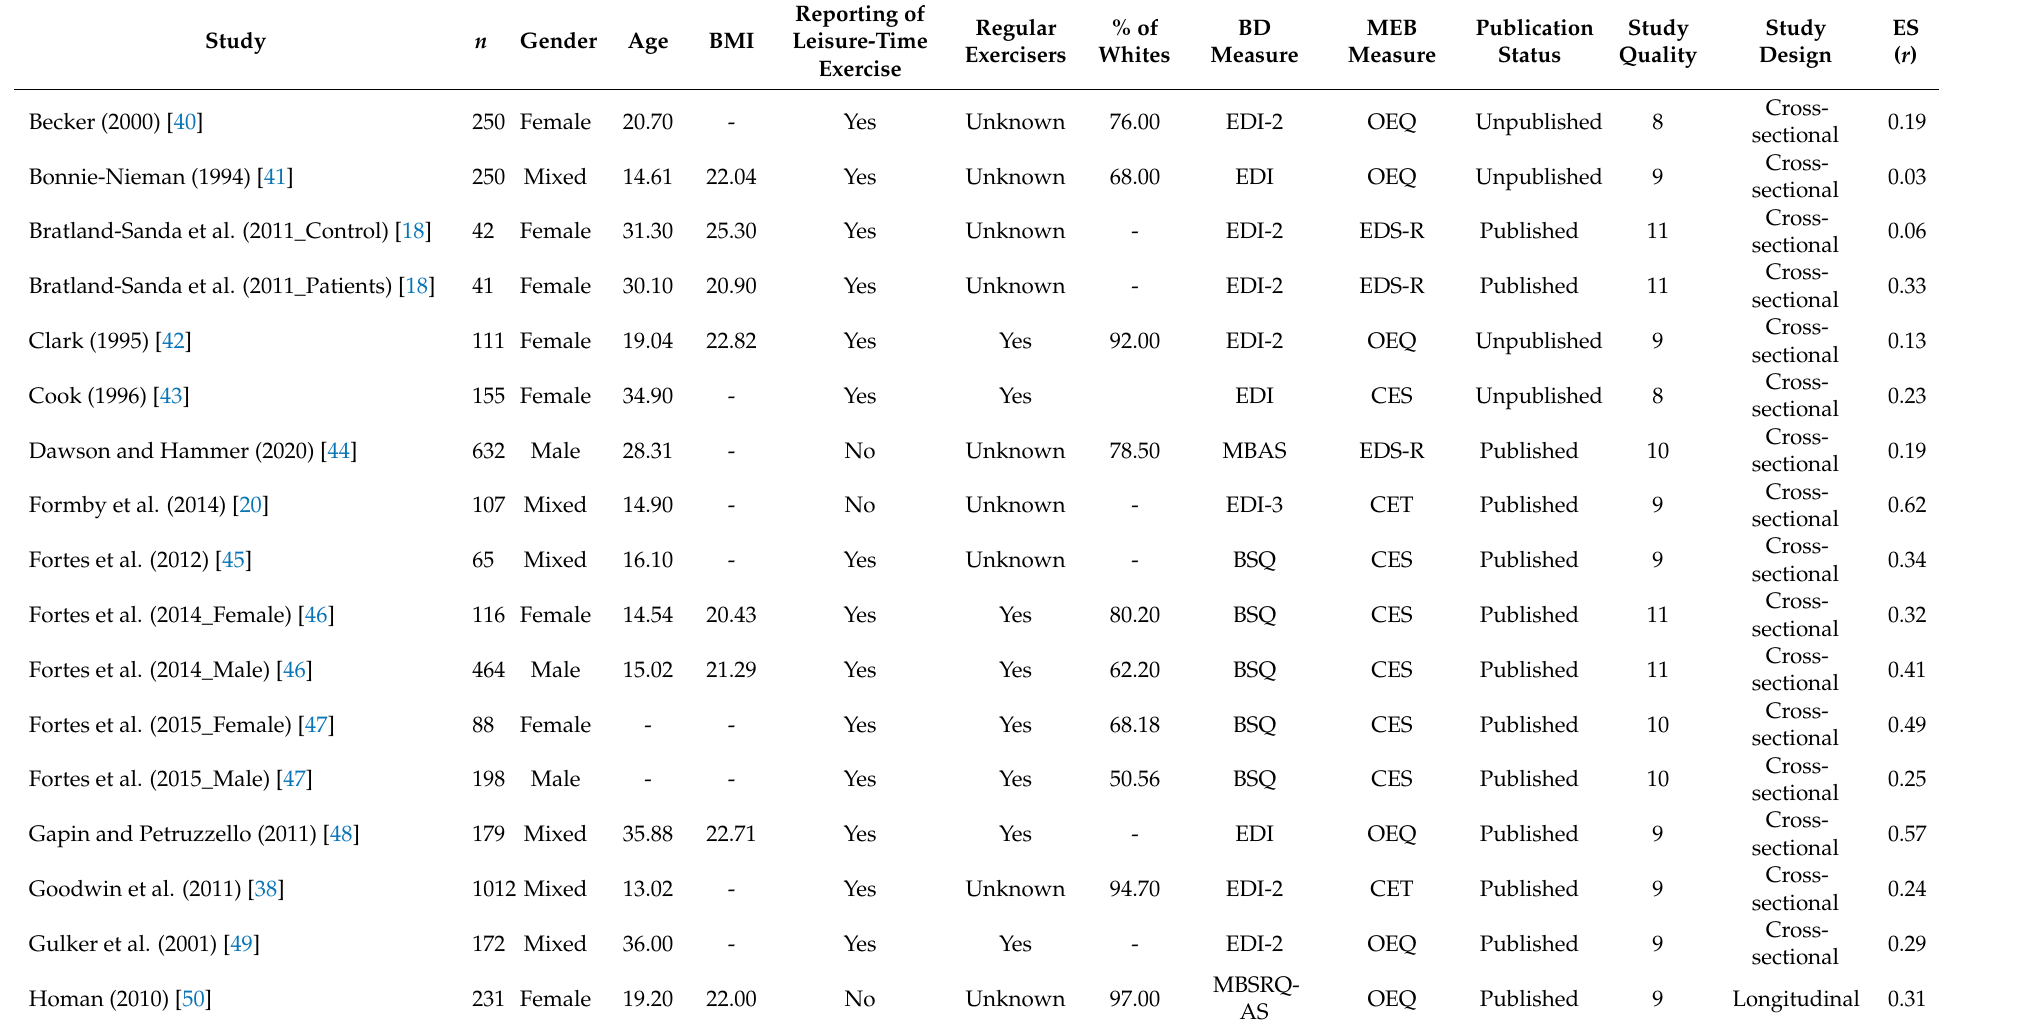
Table 1. Characteristics and effect size of the relationship between body dissatisfaction and morbid exercise